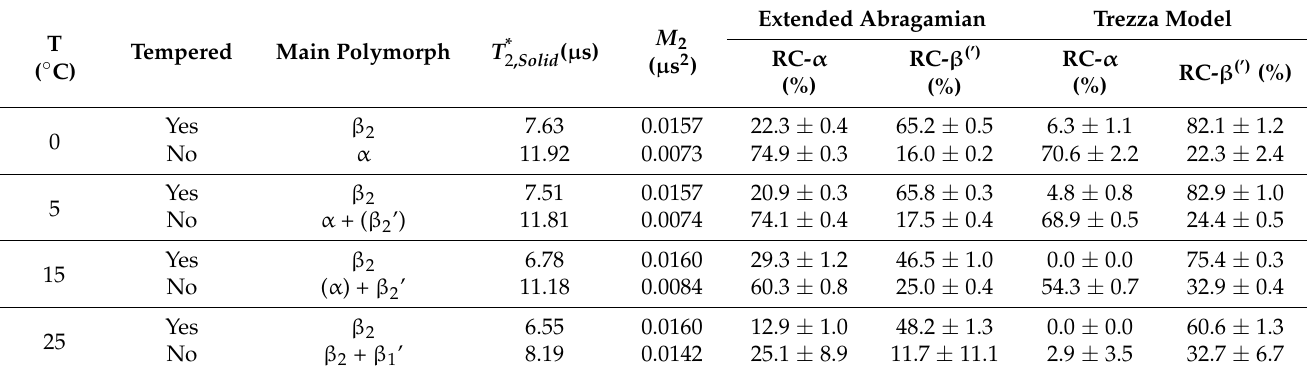
Table 8. T ∗ (based on a bi-Gaussian fit), second momentum ( M 2 ) and percentage of α and β ( ’ ) polymorphs (of the total 2, Solid crystalline phase) determined by the Extended Abragamian model and the Trezza model of tempered and non-tempered cocoa butter. For comparison, the main polymorphs as detected by XRD are indicated, whereby polymorphs between parentheses indicate that they are present in lower